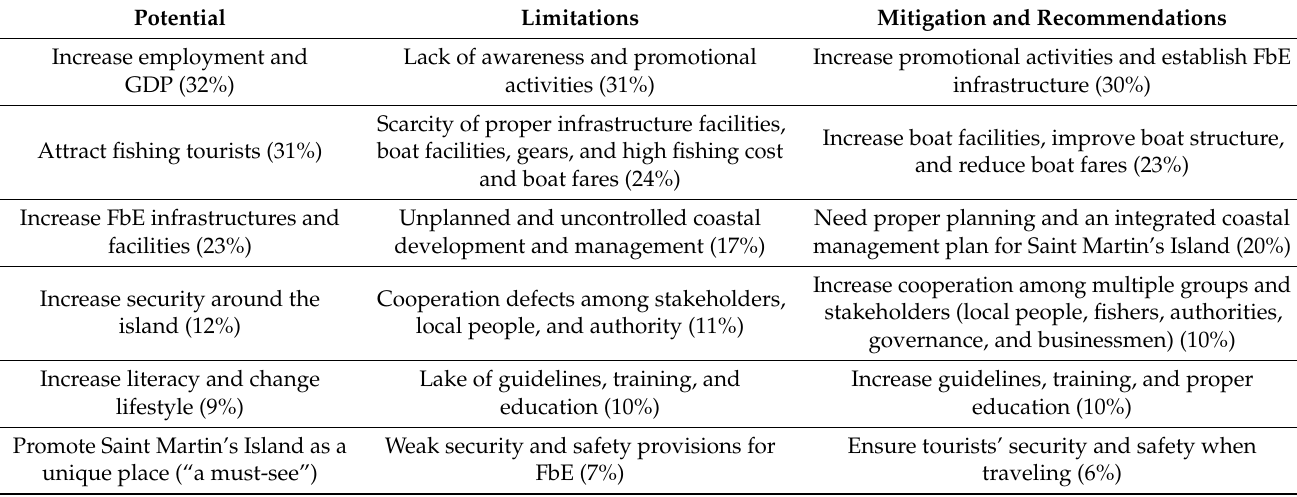
Table 2. Potential, limitations, and mitigation measures proposed by the